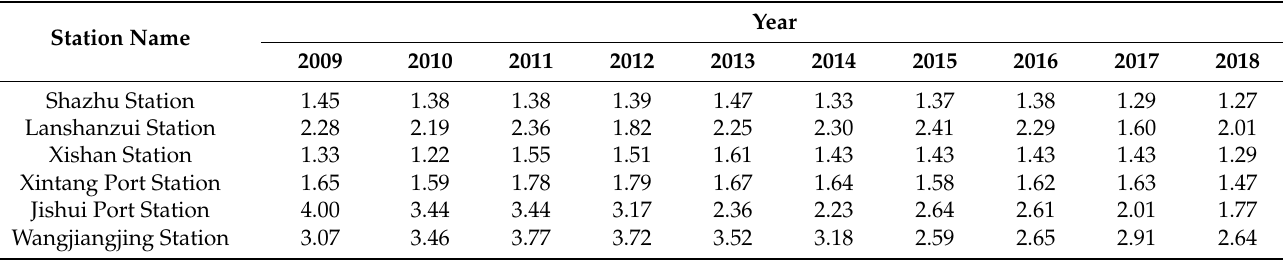
Table A16. Output values of T-S fuzzy neural network water quality